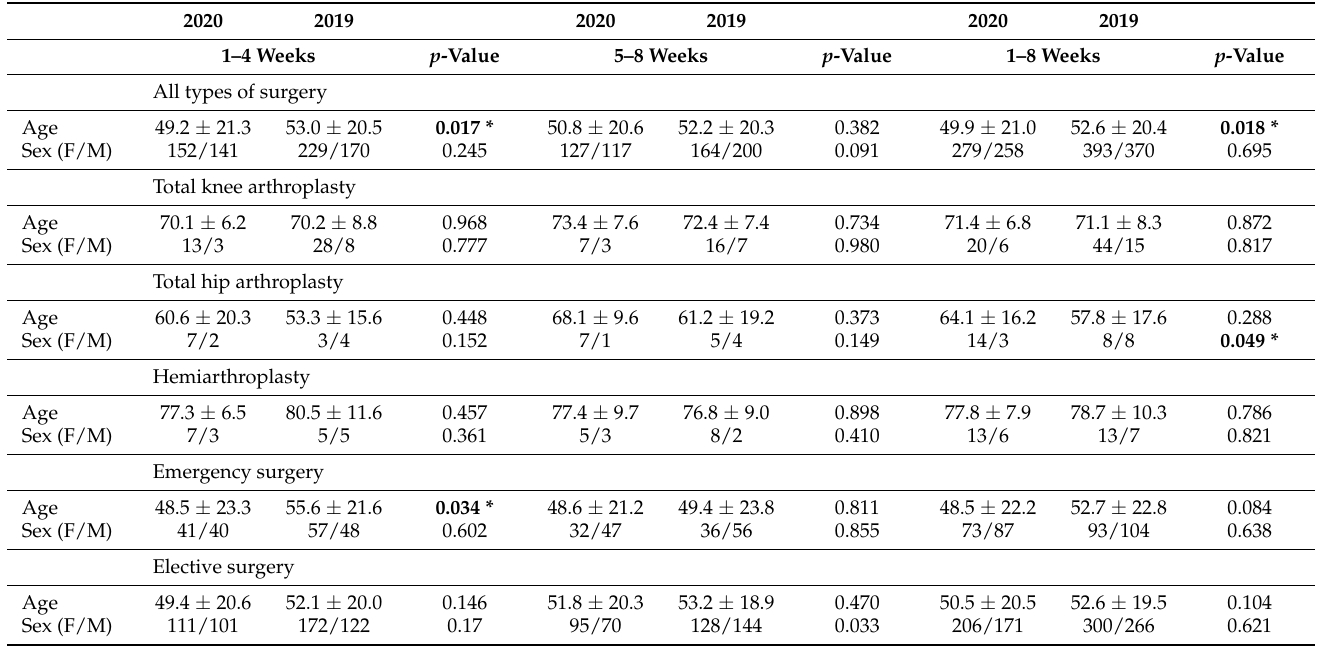
Table 2. Major characteristics of patients receiving total knee arthroplasty, total hip arthroplasty, or hemiarthroplasty surgery at the university hospital during the study (2020) and control (2019) periods; * p ≤ 0.05.